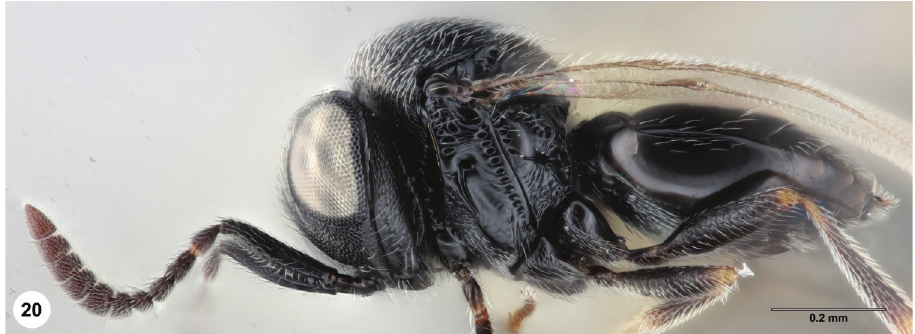
Figure 20. Trissolcus semistriatus , female (FSCA 00094876), habitus, lateral